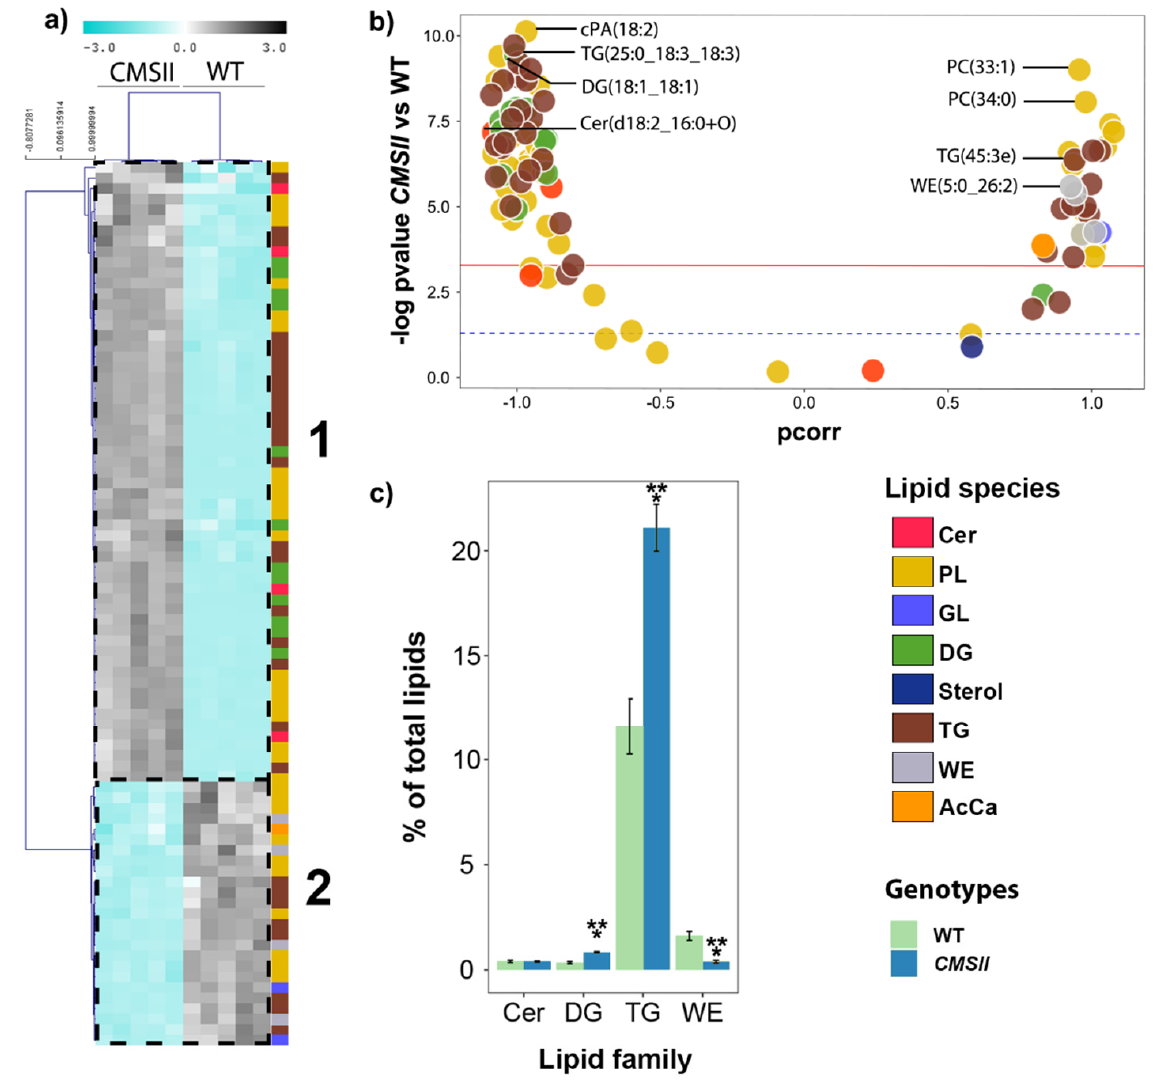
Figure 4. Pollen lipidome in tobacco from LC-MS analysis in wild-type and CMSII. ( a ) Heat map and hierarchical clustering (left) showing lipids that differ significantly ( p < 0.05, two-way ANOVA) between genotypes. Colour scale as in Figures 1 and 2. ( b ) Volcano plot showing the weight in sample discrimination (p corr value from OPLS-DA multivariate analysis) against the p -value (Welch t-test, univariate analysis) to show best lipid biomarkers between CMSII (on the left) and wild-type (on the right) pollen. ( c ) Relative quantity of lipid families of major importance in percentages of total signal. The colour legend on the right-hand side indicates lipid species families presented in the volcano plots. Genotypes are indicated with light green (wild-type) and dark turquoise (CMSII) in ( c ). A magnified version of this figure is provided in Supplementary Materials. Asterisks refer to statistical significance (***, p <